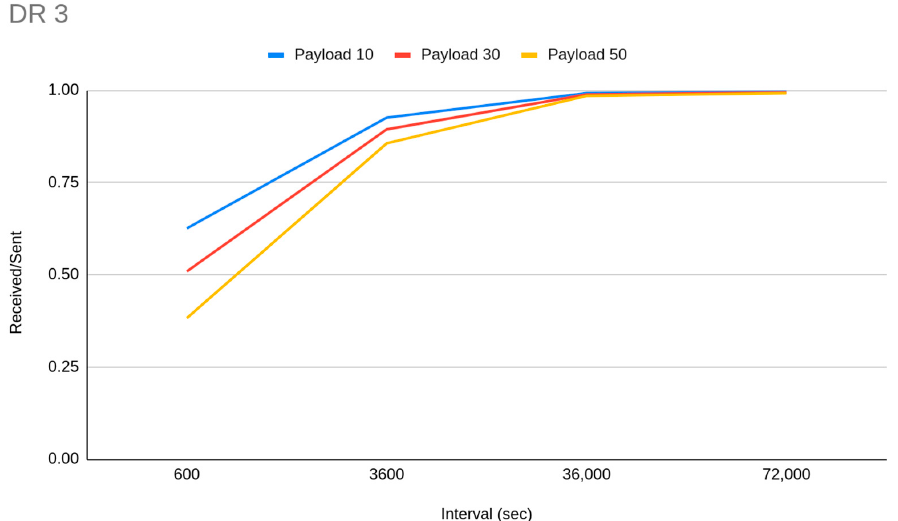
Figure 6. PDR differentiation derived from payload size and transmission interval relation.